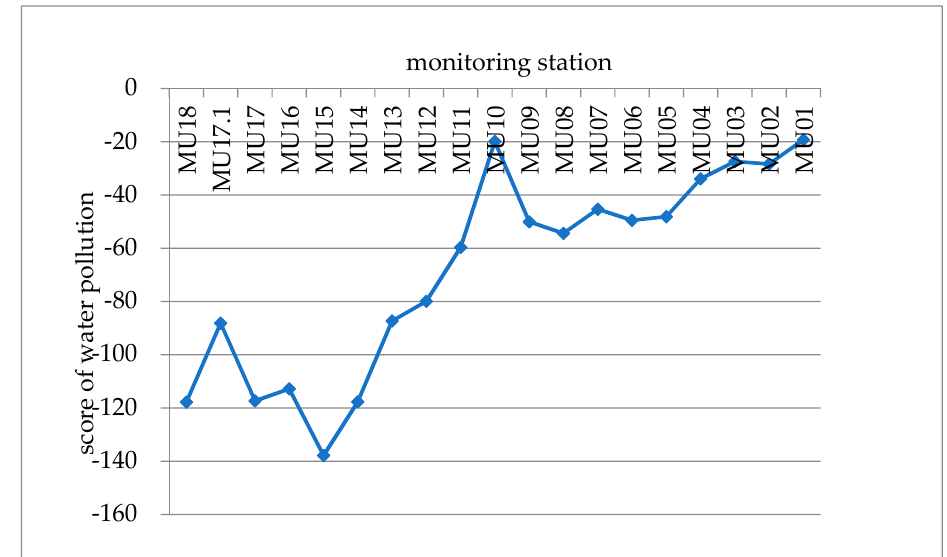
Figure 6. Comprehensive score of water pollution in the rainy season.